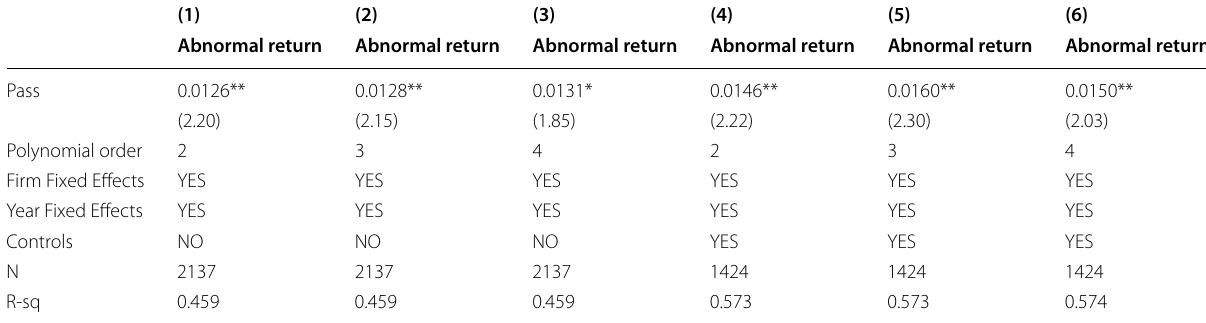
Table 9 RDD results excluding Governance proposals confounding